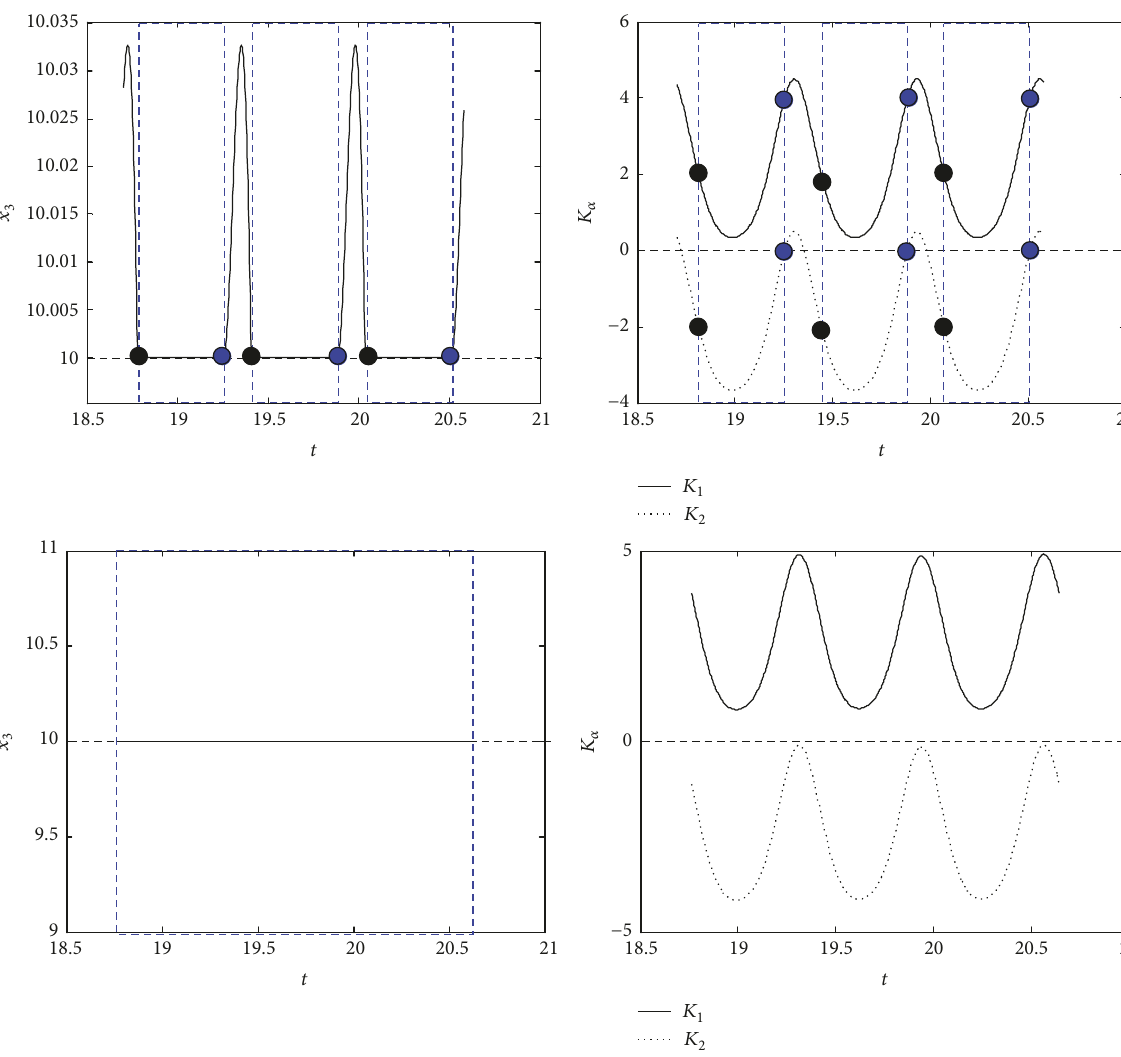
Figure 8: Time history and K -function